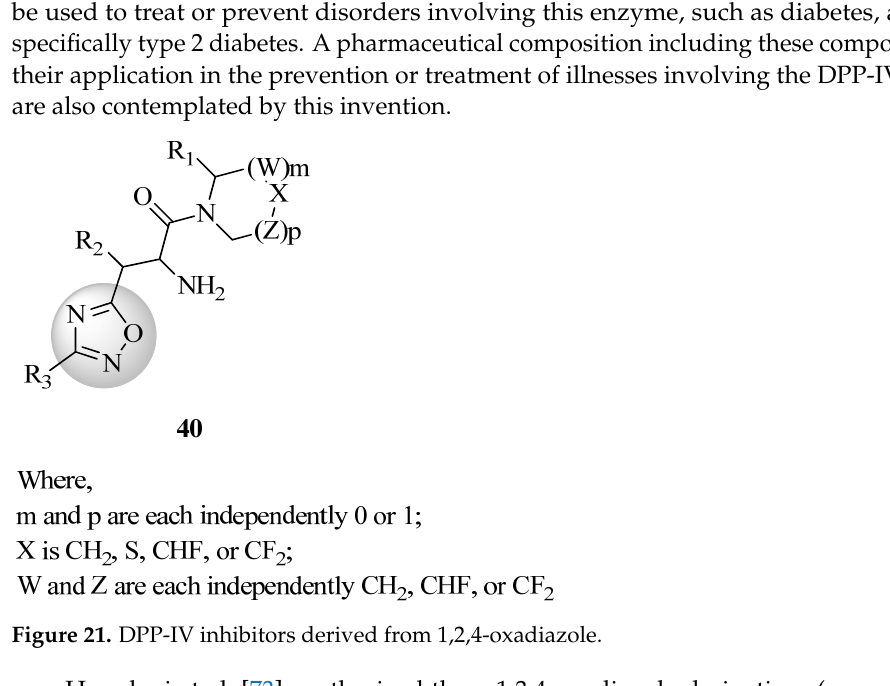
Figure 21. DPP-IV inhibitors derived from 1,2,4-oxadiazole.